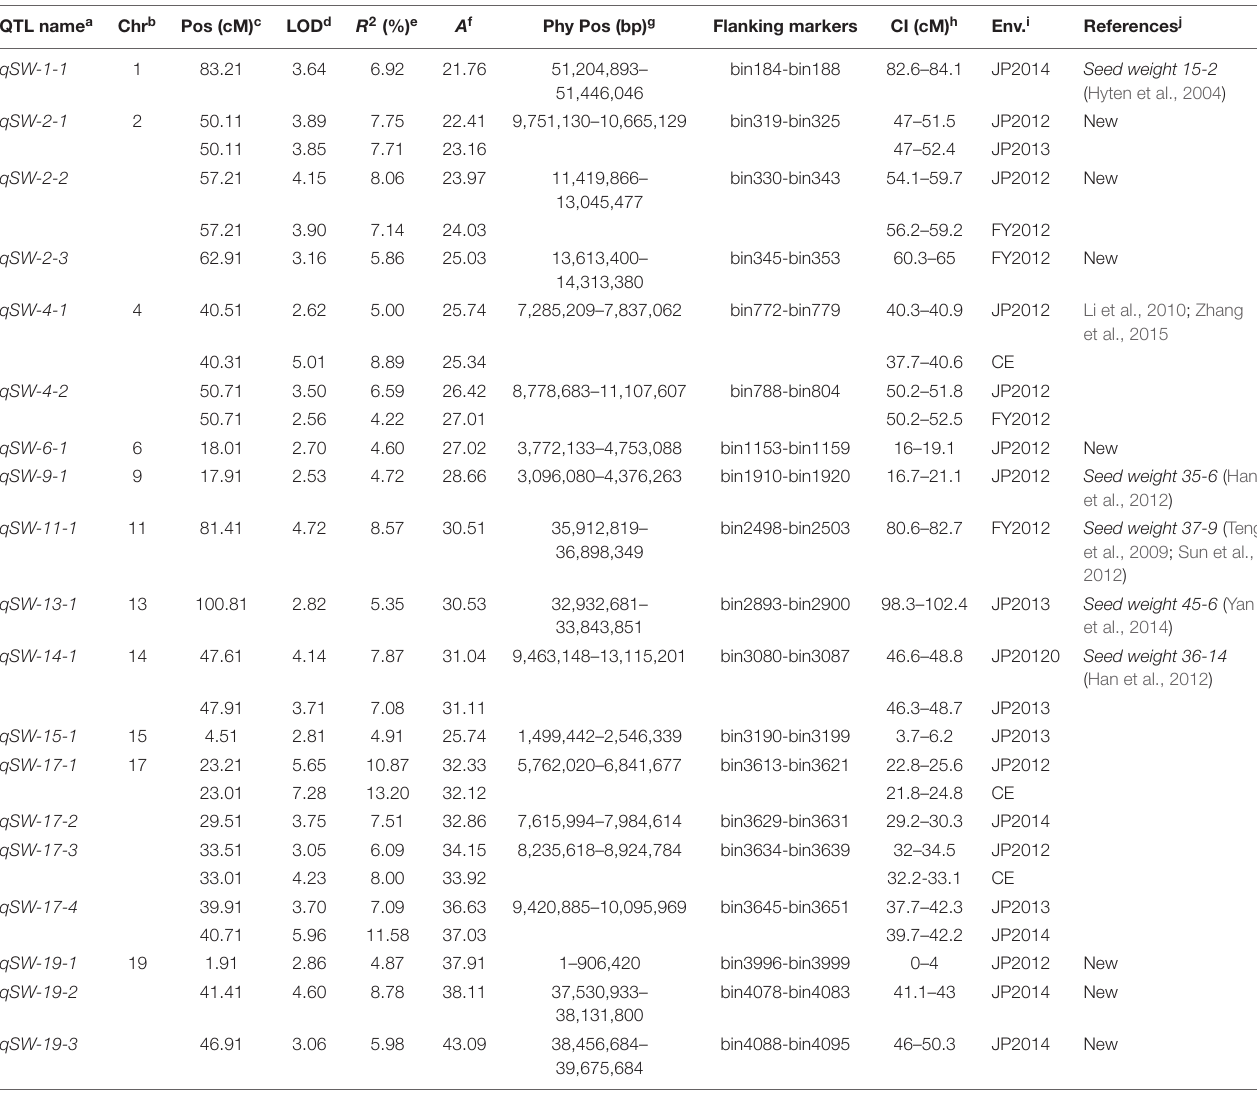
TABLE 2 | Main QTLs identified in an interspecific RIL population (NJIR4P) in four different environments (FY2012, JP2012, JP2013, and JP2014) and combined environment